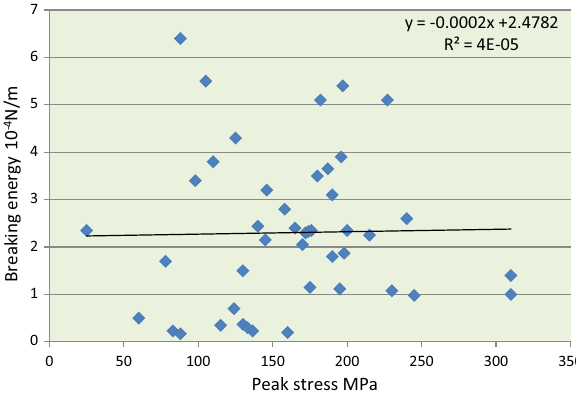
Fig. 11 Relationship between breaking energy and peak stress